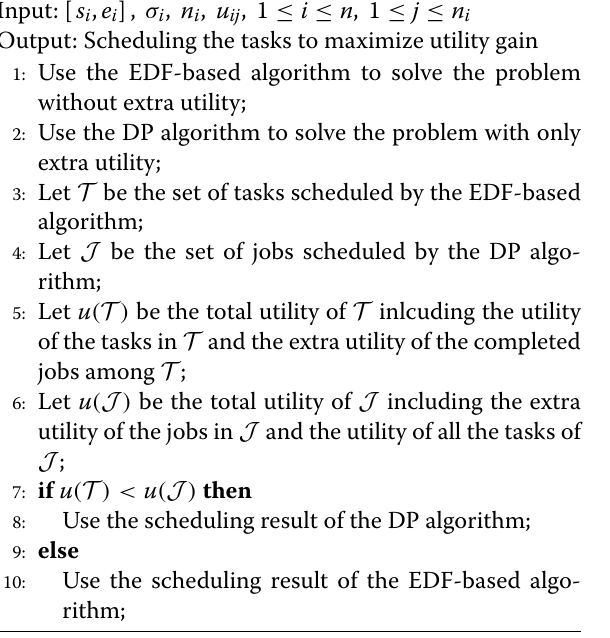
Algorithm 3 APPX1 algorithm